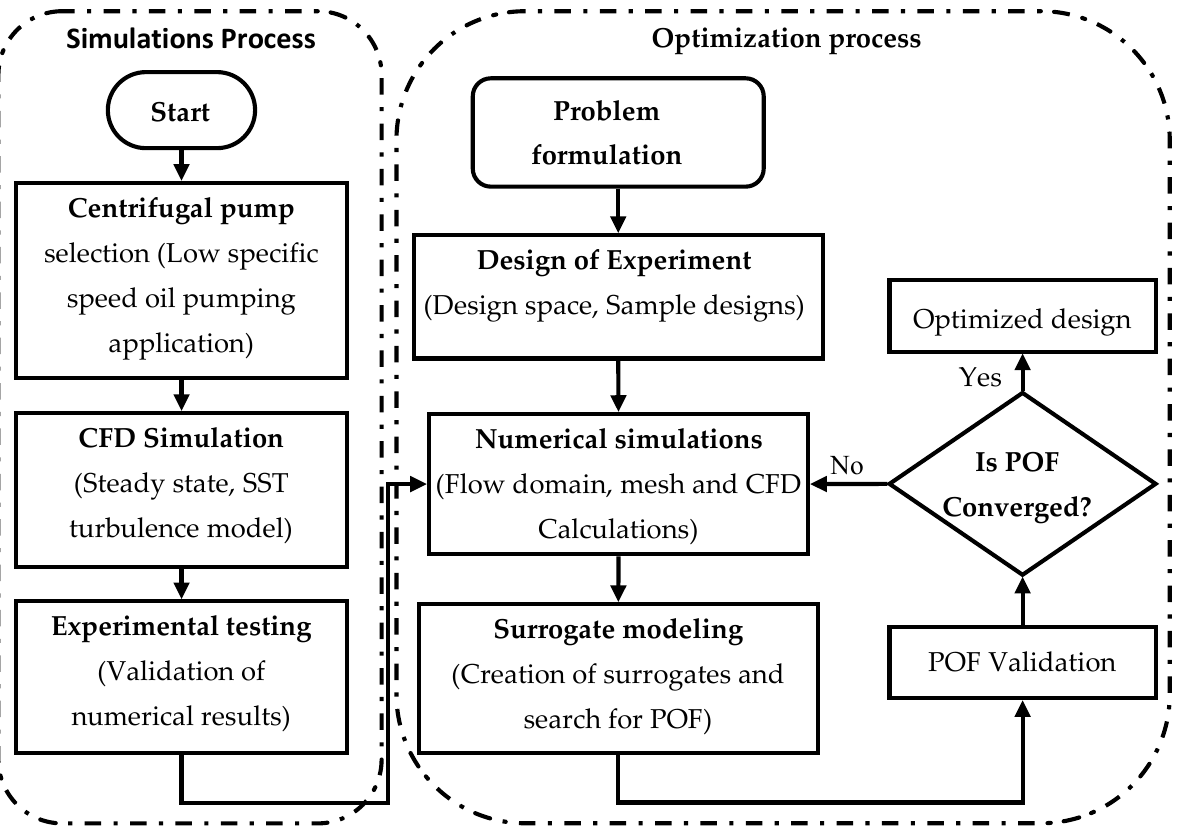
Figure 8. Flowcharts for simulation and optimization processes.